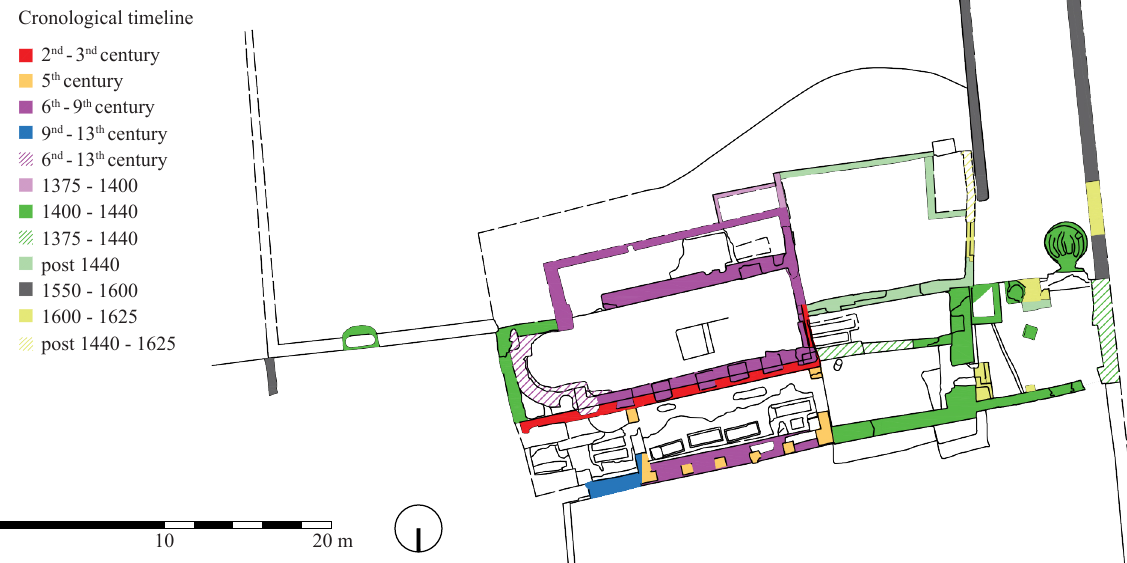
Figure 5. San Calocero’s plan with the chronological phases (drawing is based on the laser scanning survey occured in 2015, while the chronological timeline is taken from: Spadea Noviero et al., 2010. Albenga , Fratelli Frilli Editori, Genova p. 212) 10 1 :